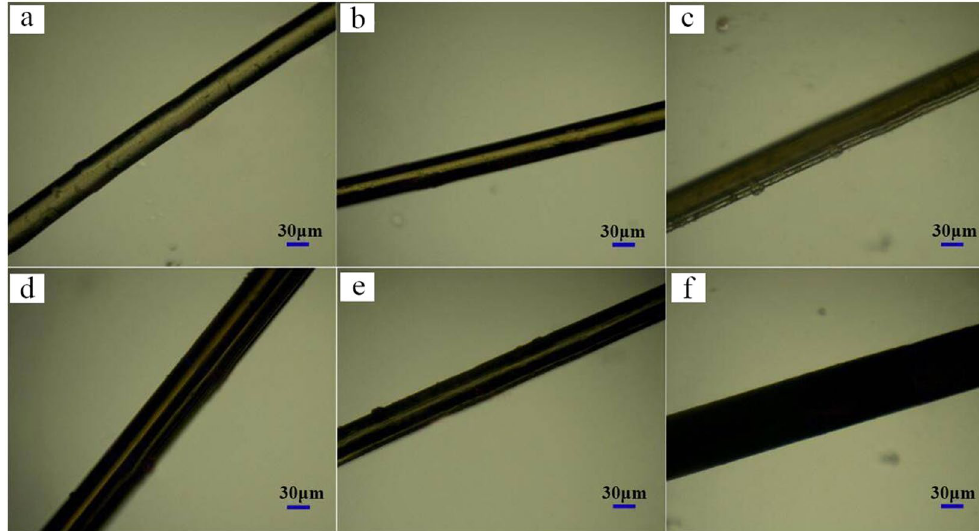
Figure 9. Micrographs of PPS/C 60 with different weight fractions of C 60 ( a ) PPS; ( b ) 0.5 wt%; ( c ) 1 wt%; ( d ) 2 wt%; ( e ) 5 wt%; ( f ) 10 wt%.